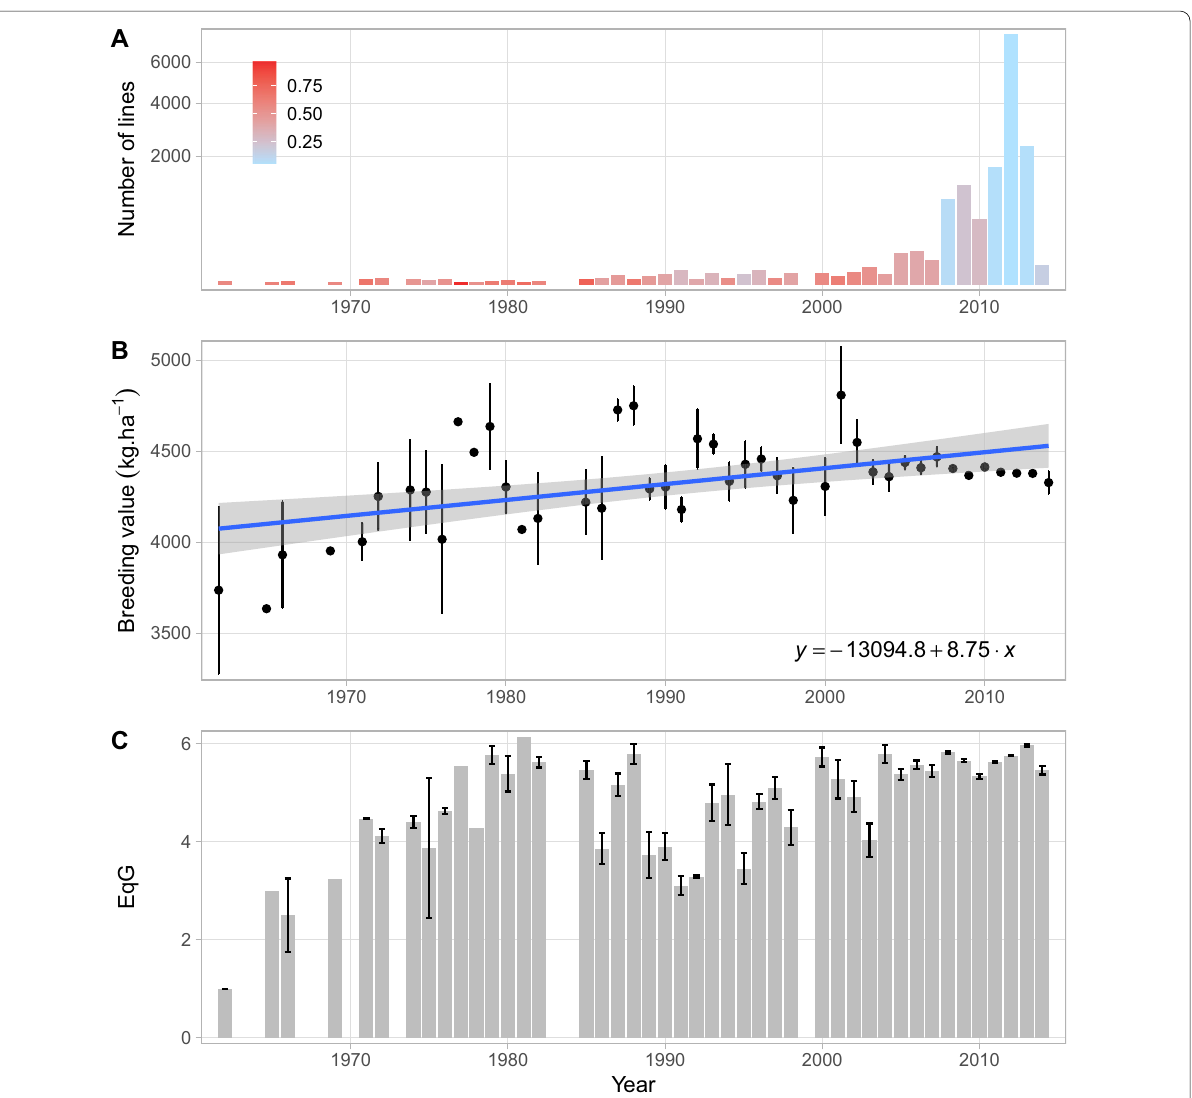
Fig. 2 Time trend of important dataset characteristics used to assess genetic gain. A Evolution of the number of lines evaluated for this analysis according to the year the cross was initially made. The color gradient indicates the average reliability associated with the breeding values for yield. B Time trend in average breeding value for grain yield across years. The error bars represent the standard error associated with the mean. The blue line represents the linear regression of the breeding value for grain yield on the year. C Evolution of the average equivalent complete generation (EqG) of the lines through time. The error bars represent the standard error associated with the